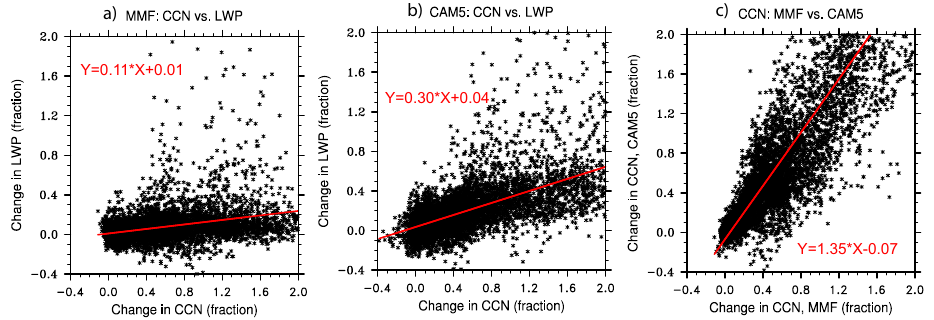
Fig. 16. Scatter plots and regressions of (a) the relative changes [(PD-PI)/PI] in annual-mean liquid water path (LWP) versus the relative changes in annual-mean CCN concentrations in the MMF model, (b) like (a) but in the CAM5 model; (c) the relative changes in annual- mean CCN concentrations (at 0.1% supersaturation) in CAM5 versus that in the MMF. LWP in CAM5 only includes the contribution from large-scale clouds. Annual mean data are sampled on each GCM grid column from 60 ◦ S to 60 ◦ N. CCN concentrations are averaged over the lowest 8 model levels (surface to about 800hPa). Red lines and equations are from the linear